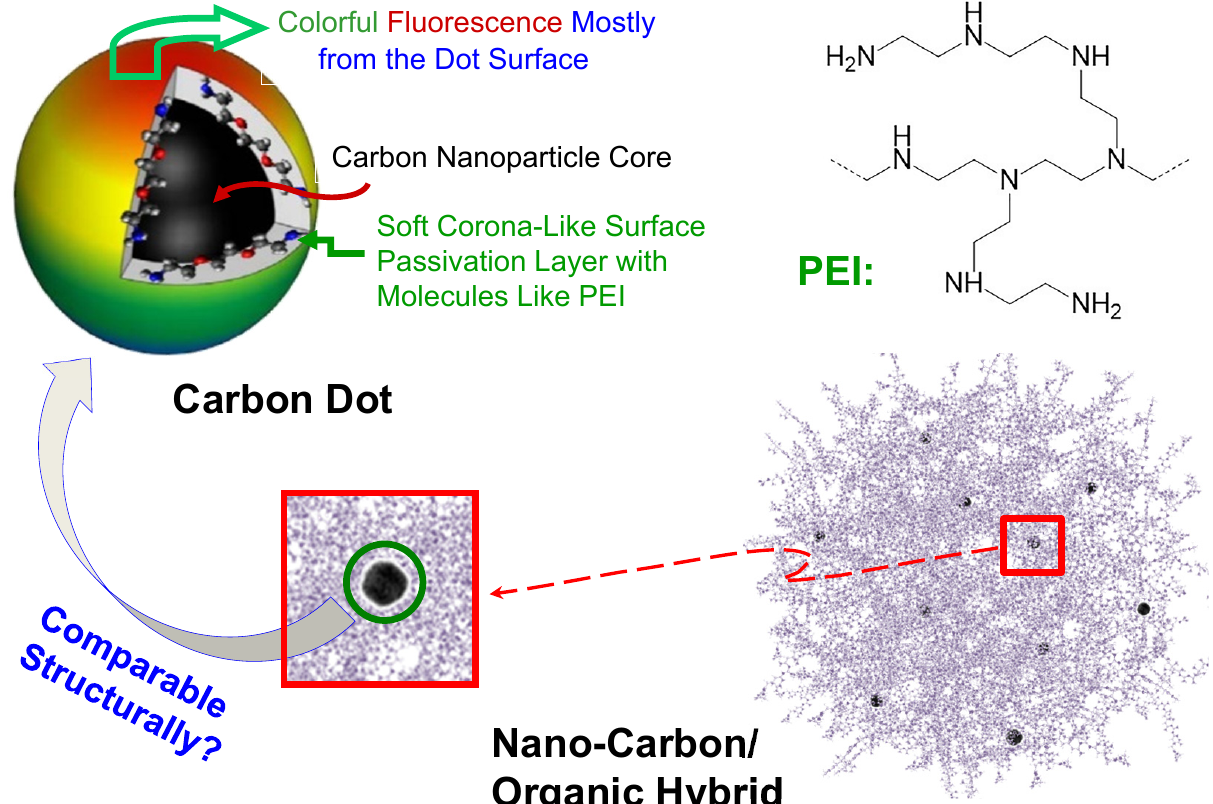
Figure 1. Carbon dots (PEI-CDots as a specific example, classically defined and prepared by the functionalization of preexisting small-carbon nanoparticles with PEI molecules) versus the nanocar- bon/organic hybrids from the thermal processing of selected organic